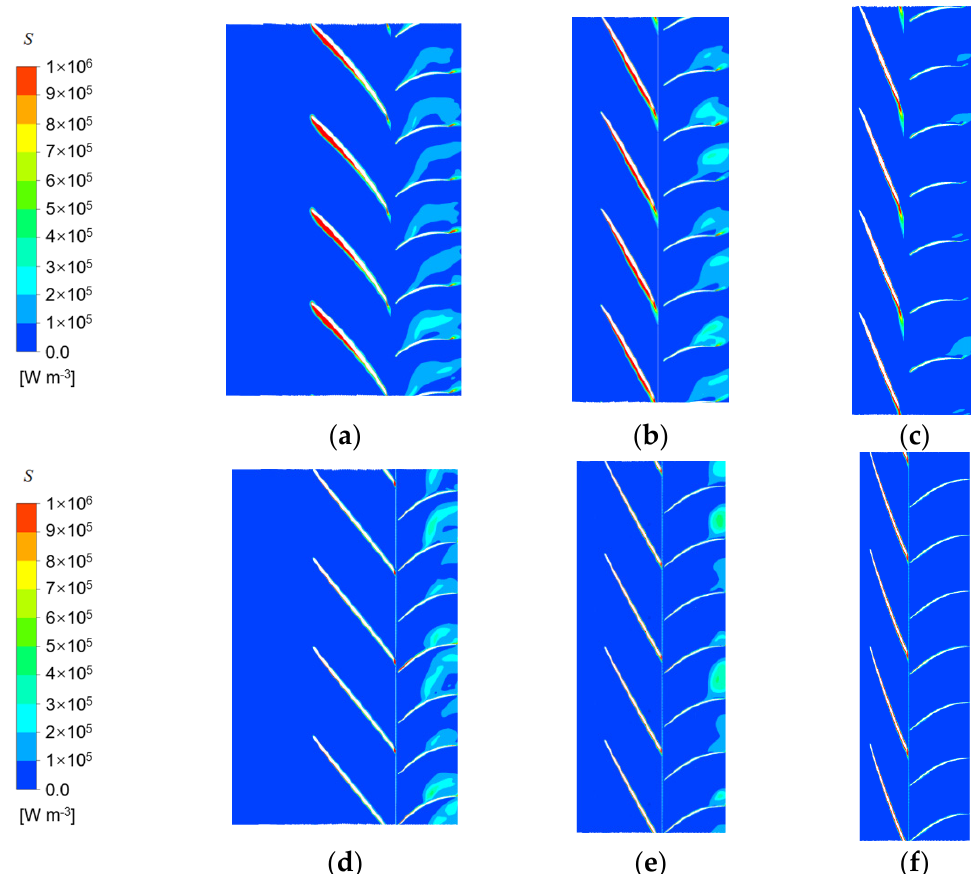
Figure 14. Comparison of volume entropy production power in different spanwise. ( a ) Initial scheme at span = 20%. ( b ) Initial scheme at span = 50%. ( c ) Initial scheme at span = 80%. ( d ) Optimized scheme at span = 20%. ( e ) Optimized scheme at span = 50%. ( f ) Optimized scheme at span =